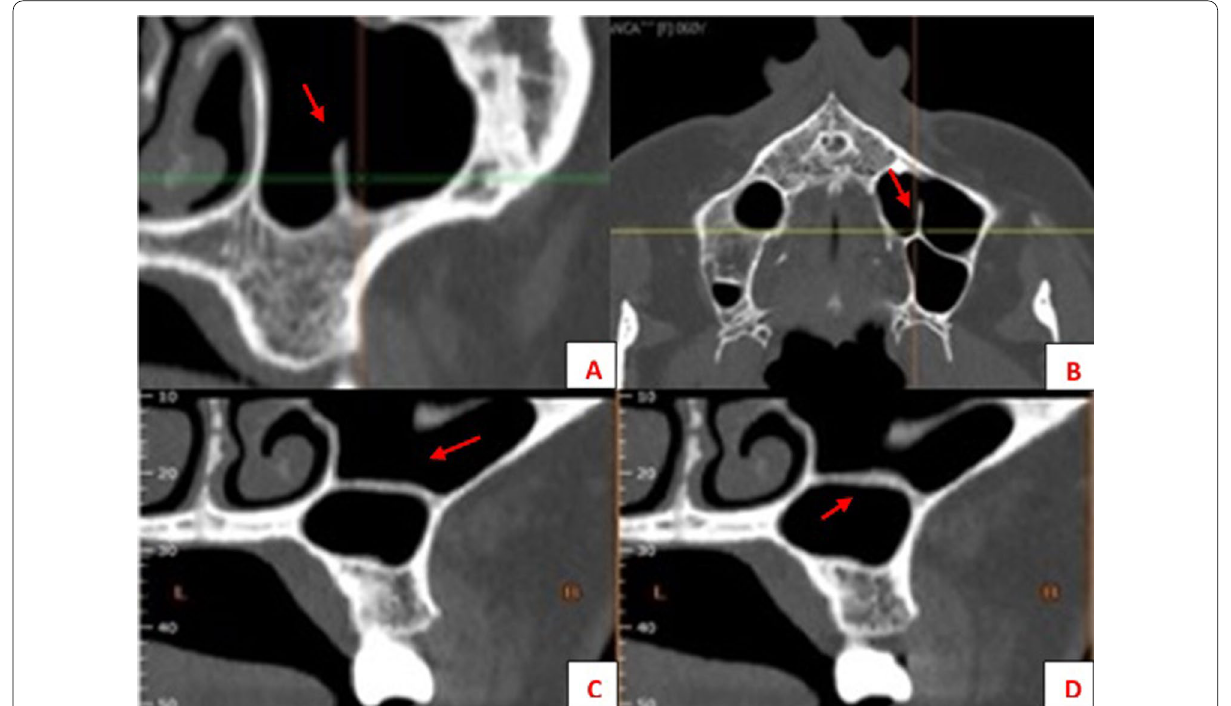
Fig. 6 Different orientations of MSS: ( A ) sagittal, ( B ) sagittal